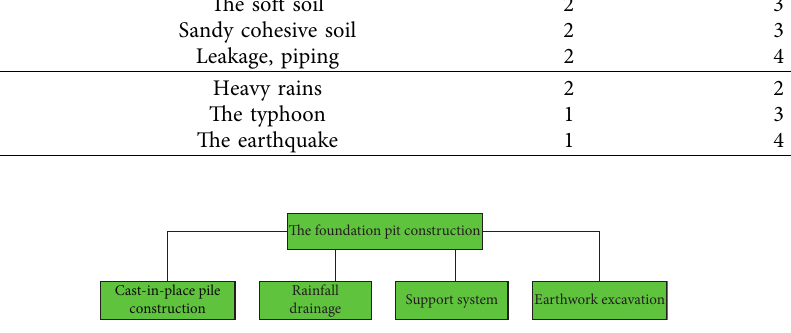
Figure 4: Risk level chart of foundation pit